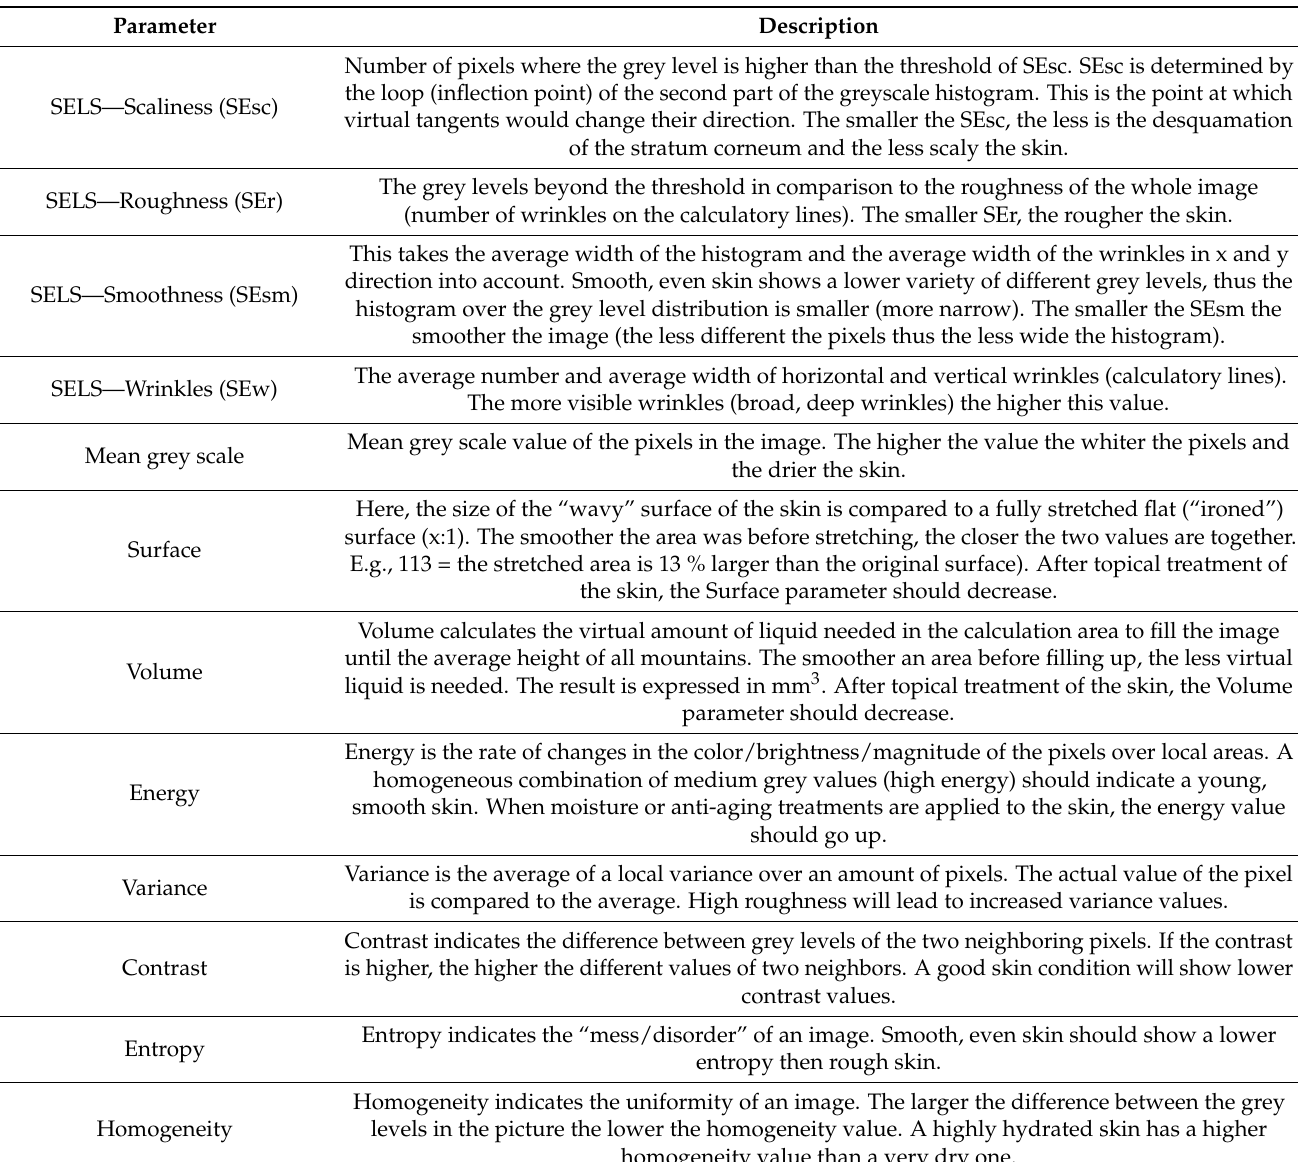
Table 1. Summary of Visioscan ® VC 20plus measurement parameters